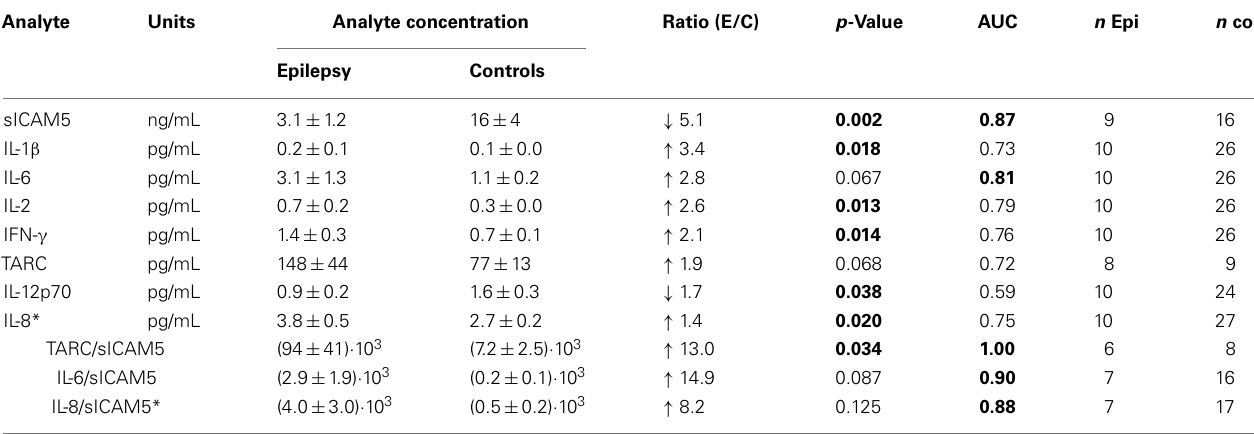
Table 2 | Levels of cytokines and chemokines in plasma that significantly distinguish between epilepsy patients and controls. Analyte Units